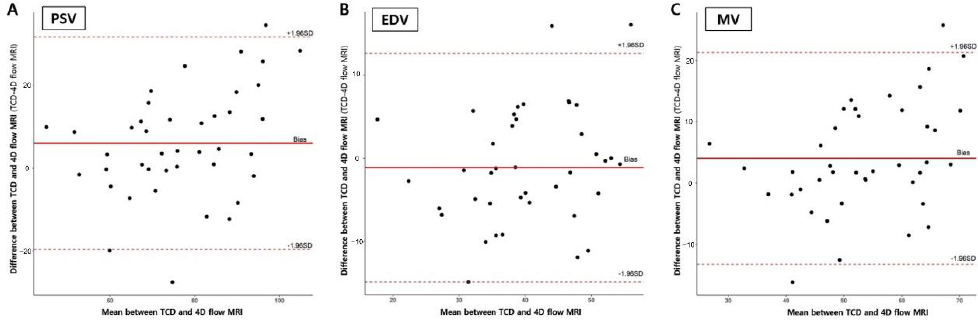
Figure 3. Bland-Altman plots of four-dimensional flow MRI compared with transcranial Doppler ultrasound in the proximal M1 segments. ( A ) Peak systolic velocity; ( B ) End diastolic velocity; ( C ) Mean velocity.